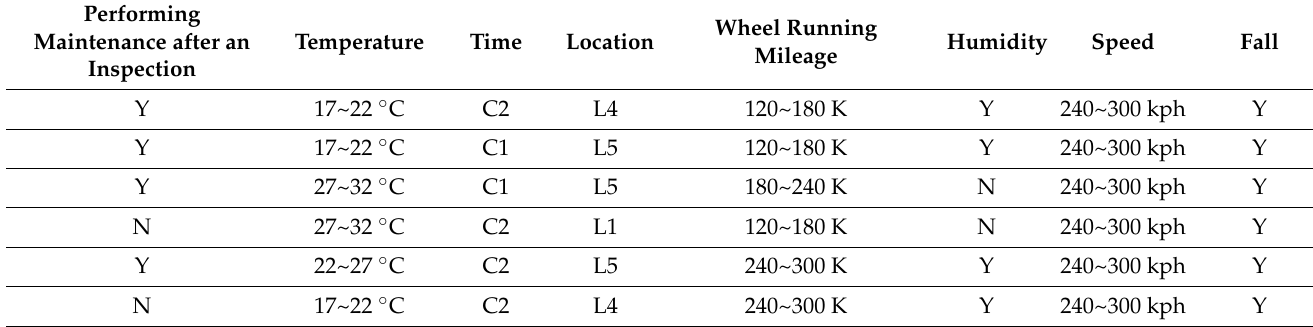
Table 11. Partial sample set of original data.